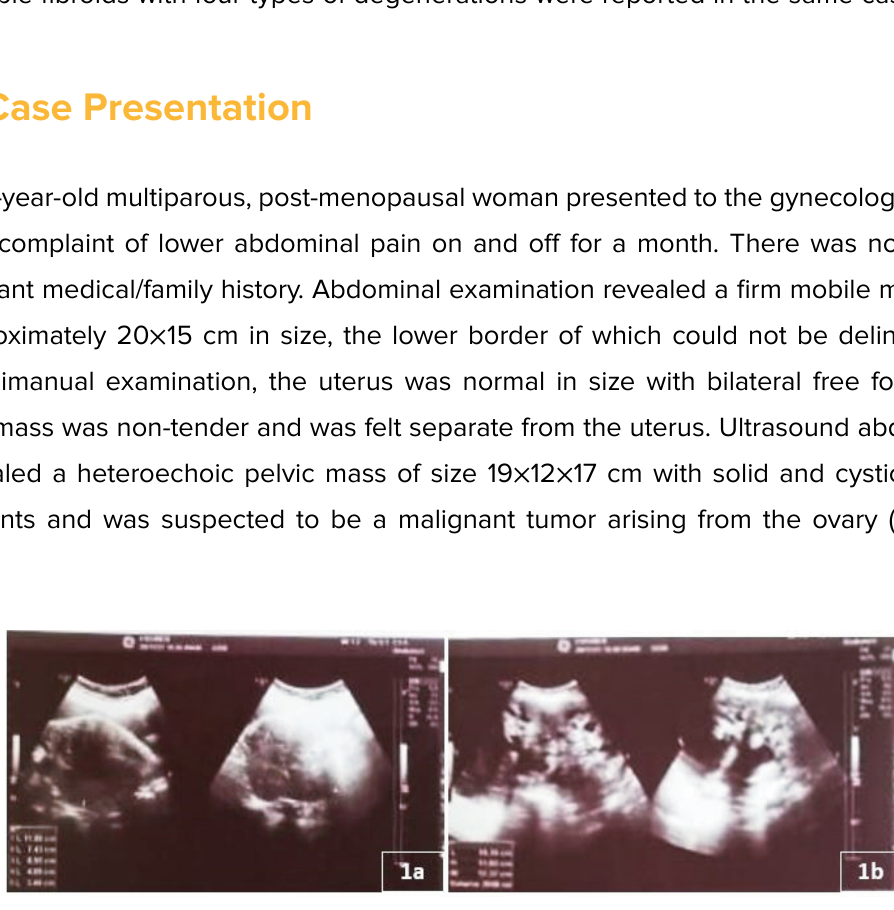
Figure 1 : Ultrasound image showing a heteroechoic pelvic mass with solid and cystic